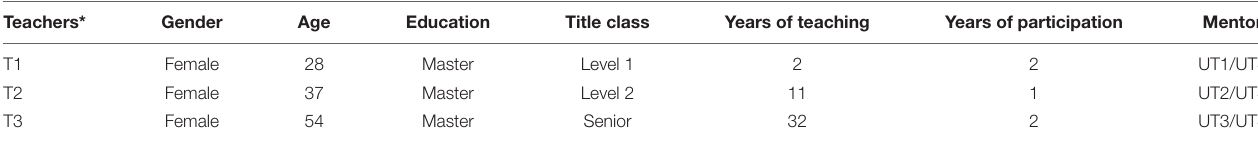
TABLE 1 | The profile of school